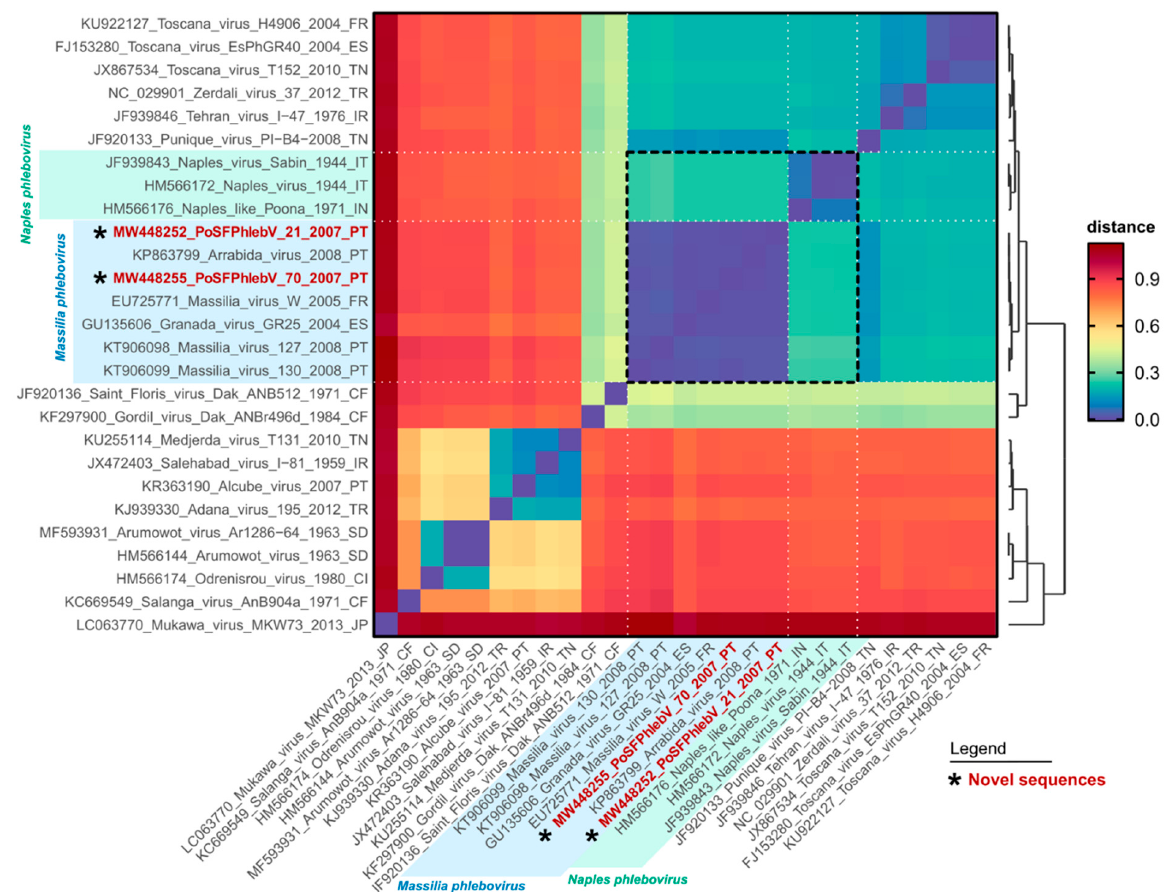
Figure 2. Pairwise genetic distance heatmap of phleboviruses RNA-dependent RNA polymerase protein sequences. Each cell shows the genetic distance between pairs of sequences ( y versus x axis), colored according to the scale presented on the right. The dendrogram on the right was built using the pairwise distances with the base function hclust in R, and is reflective of the named sequences on the y axis. Sequence names in red and marked with an asterisk have been sequenced in this study. The shaded areas on the axes highlight the classic Massilia phlebovirus group (blue) and the newly renamed Naples phlebovirus group (green). The dashed black square in the heatmap highlights the distance results for the sequences of the Massilia and Naples groups. The sequences used for this output are the same presented in Figure 1. Original pairwise distance data is presented in Table S2: Estimates of evolutionary divergence between phleboviruses’ RdRp aa sequences.